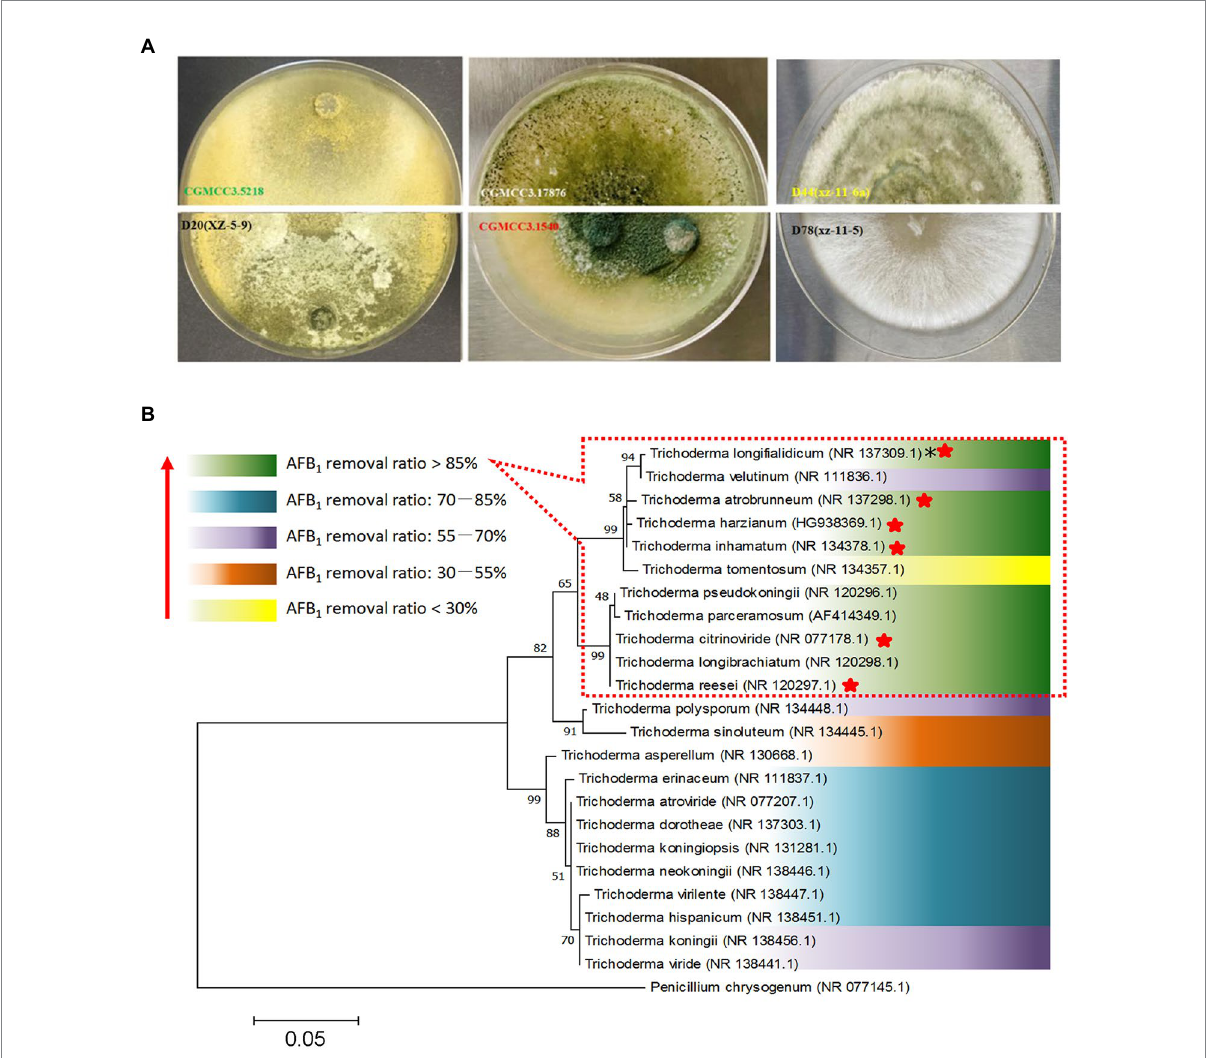
FIGURE 2 Screening of different Trichoderma isolates for aflatoxin detoxification. (A) The colonial morphology of T. reesei CGMCC3.5218, T. citrinoviride D20 (xz-5-9), T. harzianum CGMCC3.17876, T. atrobrunneum CGMCC3.1540, T. inhamatum D44 (Xz-11-6a), and T. longifialidicum D78 (xz-11-5) cultured in potato dextrose agar (PDA) after 5 days of incubation at 28 ° C in the dark. (B) The relationships between Trichoderma evolution and aflatoxin B 1 (AFB 1 ) removal ability. The abilities of different species to remove AFB 1 are divided into five levels, which are represented by different colors according to the mean value of AFB 1 removal ratios of different intra-species strains. *NR: The code of the reference internal transcribed spacer (ITS) sequence obtained from the website of the National Center for Biotechnology Information (NCBI). The top six species having a higher AFB 1 (50 ng/kg) removal efficiency were marked by red